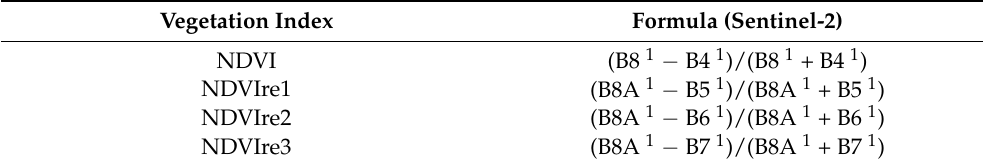
Table 3. Vegetation index used in the article. The bands in the calculation formula correspond to the Sentinel-2